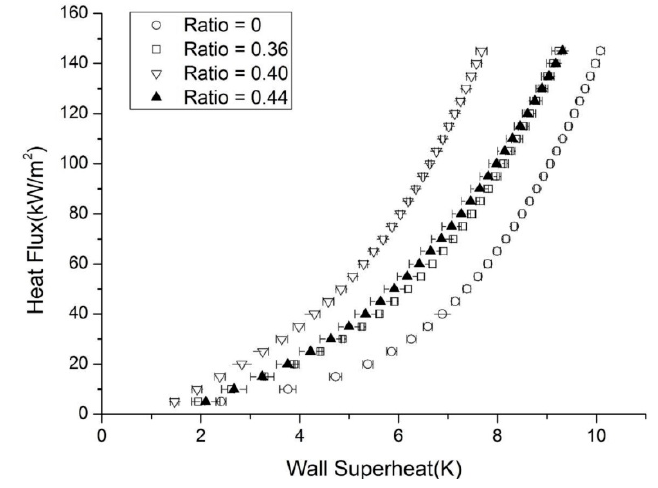
Figure 11. The effect of the pitch on the pool boiling curves of the various tested surfaces.